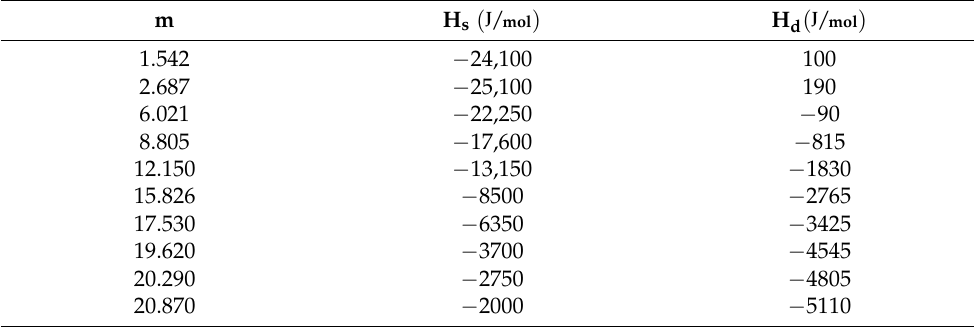
Table A27. Coefficients of the H 2 O-Ca(NO 3 ) 2 enthalpy